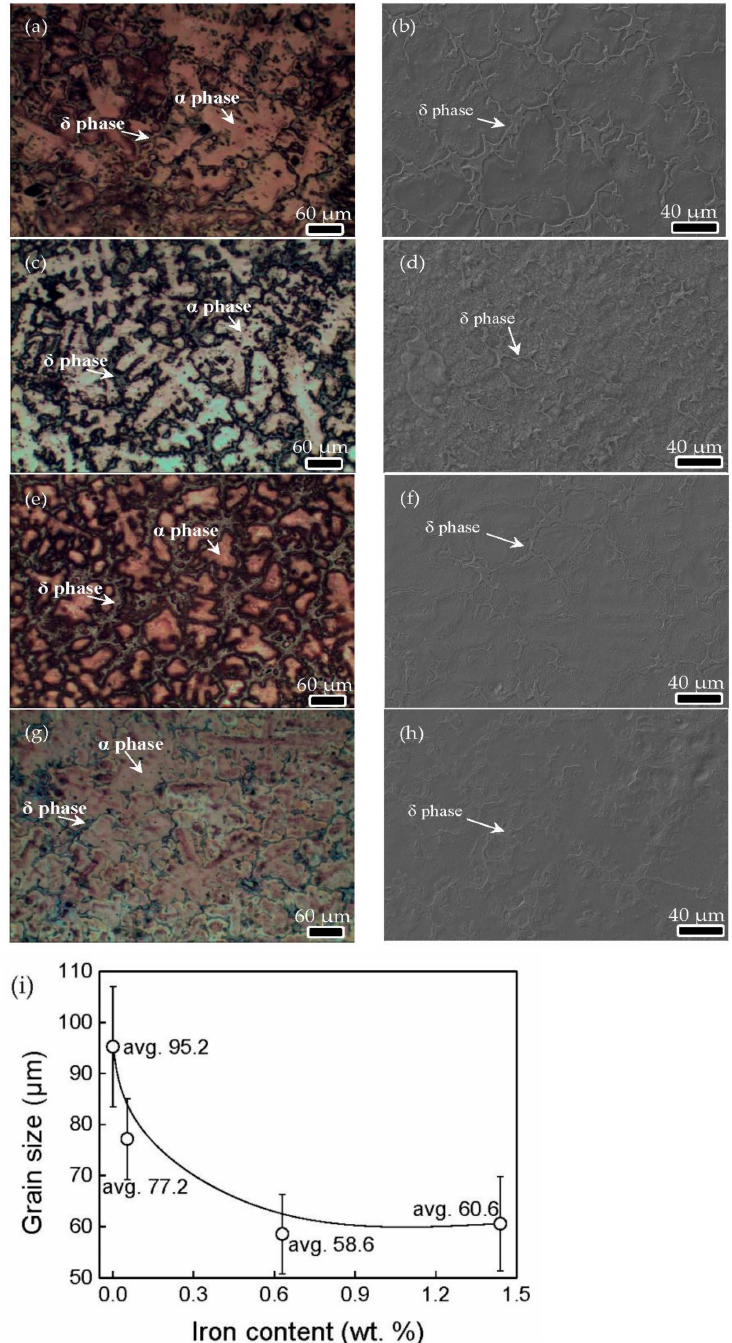
Figure 7. ( a , c , e , g ) OM and ( b , d , f,h ) SEM micrographs of cast ( a , b ) Cu-12Sn-1.5Ni; ( c , d ) Cu-12Sn- 1.5Ni-0.05Fe; ( e , f ) Cu-12Sn-1.5Ni-0.5Fe; ( g , h ) Cu-12Sn-1.5Ni-1.5Fe alloys. Dendritic or grain matrix of α phase and interdendritic δ phase were indicated by white arrows and labels; ( i ) Grain as a function of iron content in cast Cu-12Sn-1.5Ni-xFe alloys